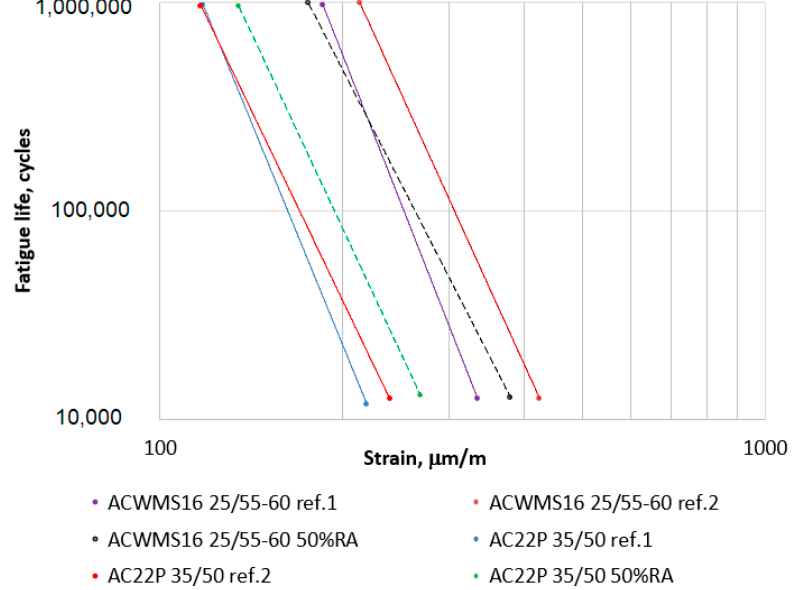
Figure 4. Graphical representation of the fatigue characteristics of mixtures with reclaimed asphalt and reference mixtures.